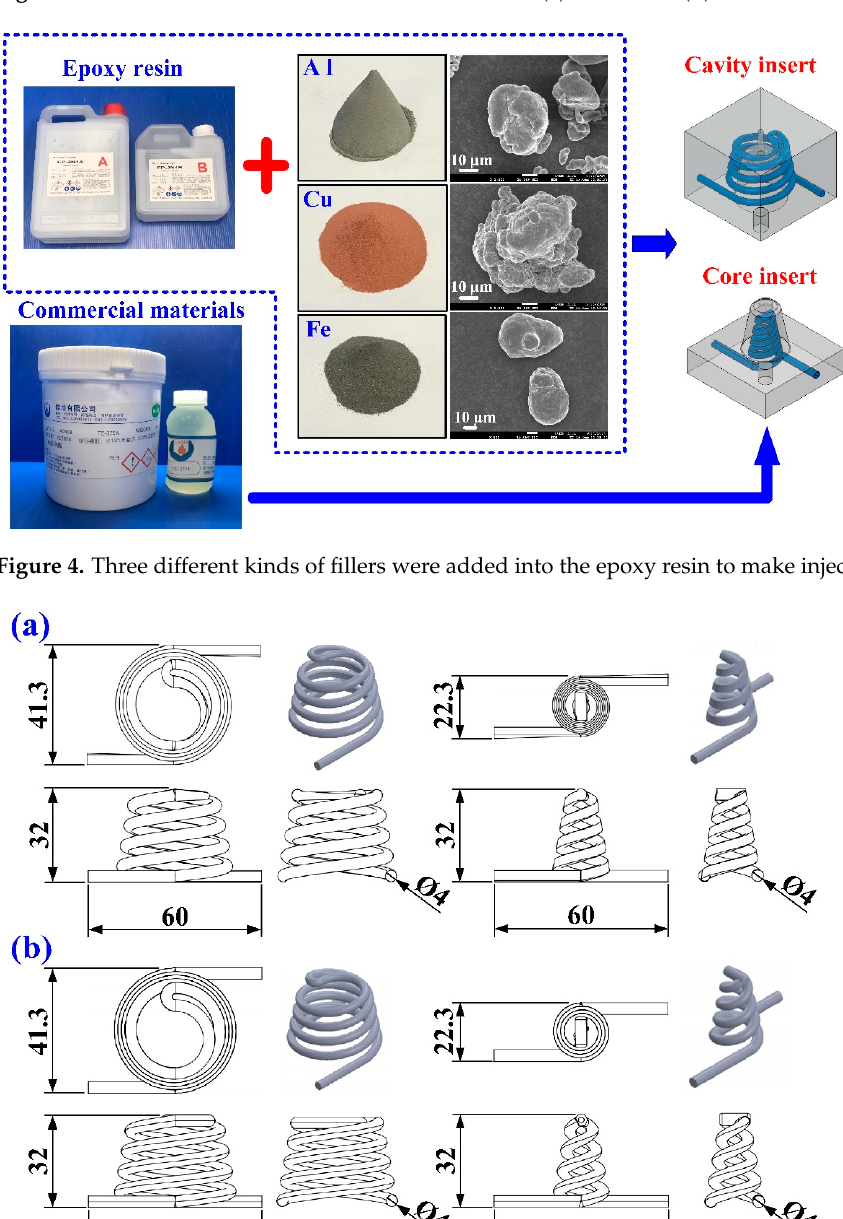
Figure 3. Schematic illustrations of the cross-section of ( a ) PCCC and ( b ) CCCC.